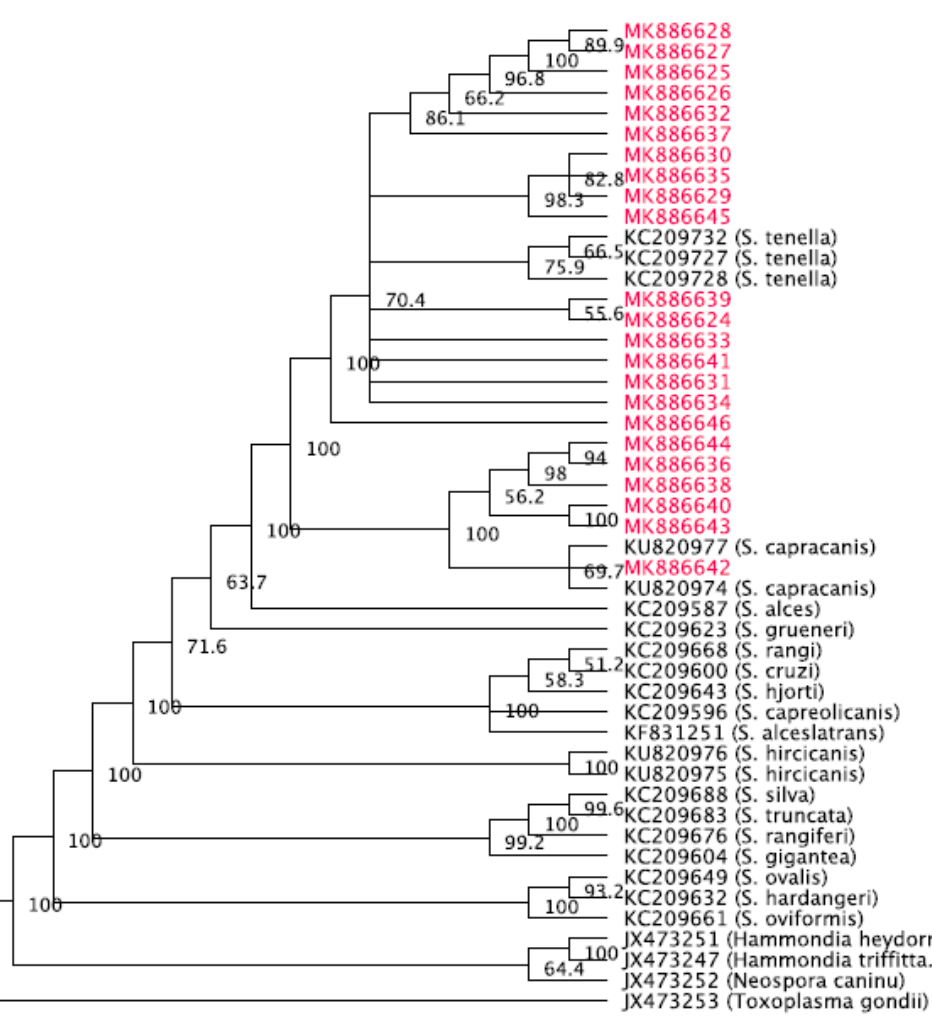
Figure 2. Phylogenetic tree of the 23 samples along with several sequences published in GenBank.